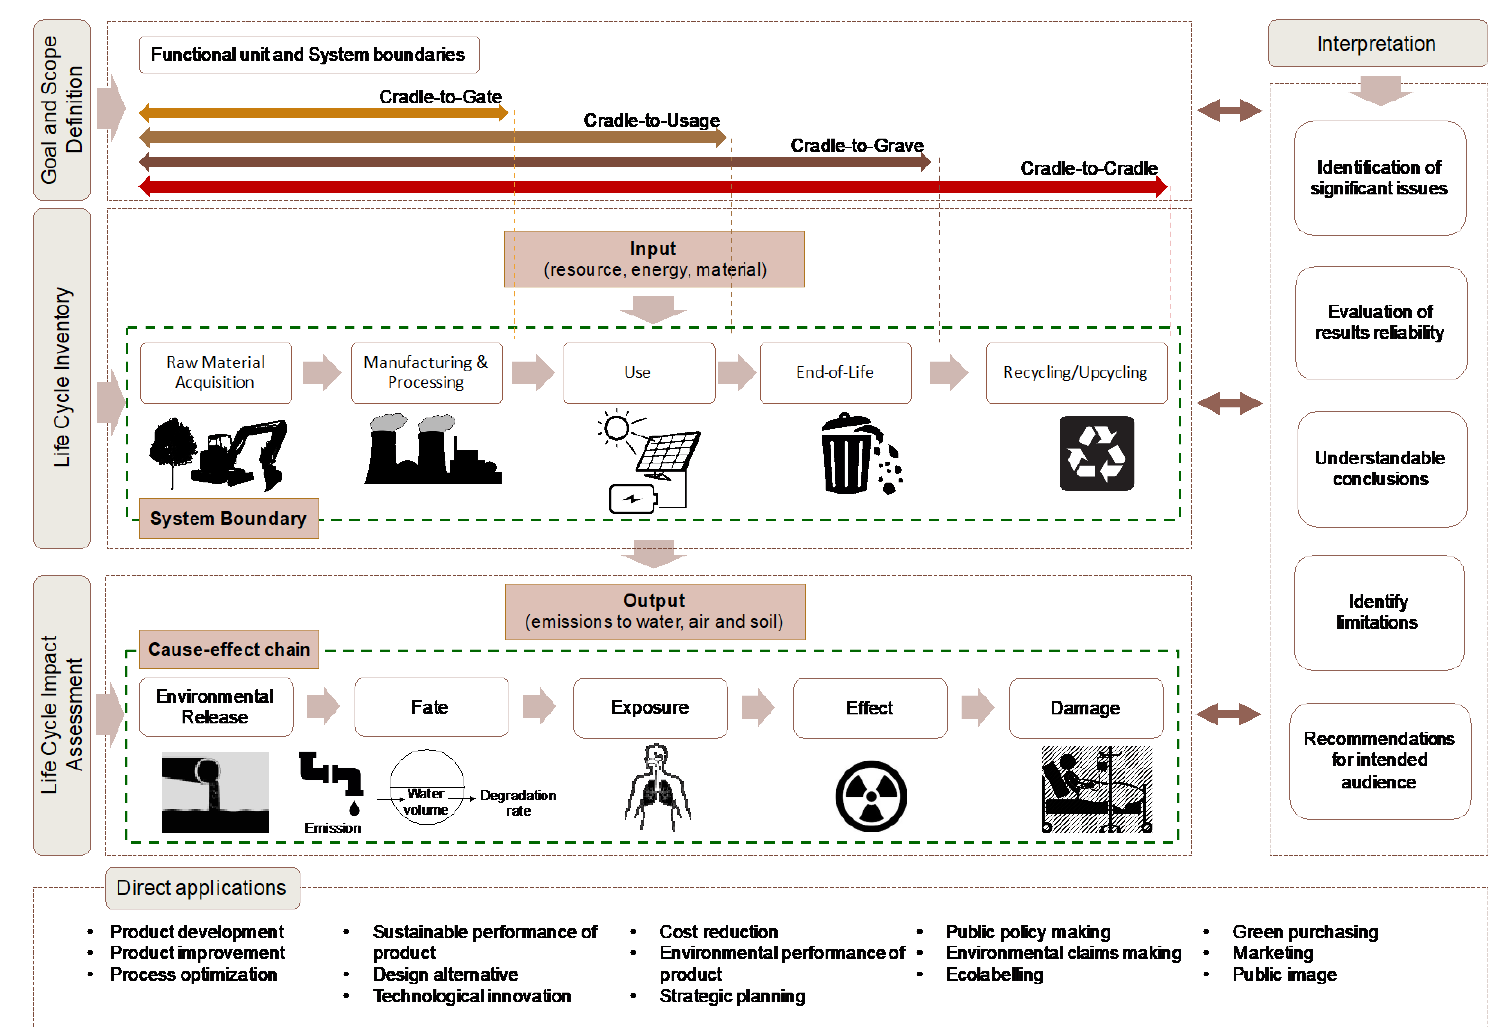
Figure 2. A generic life cycle assessment framework.